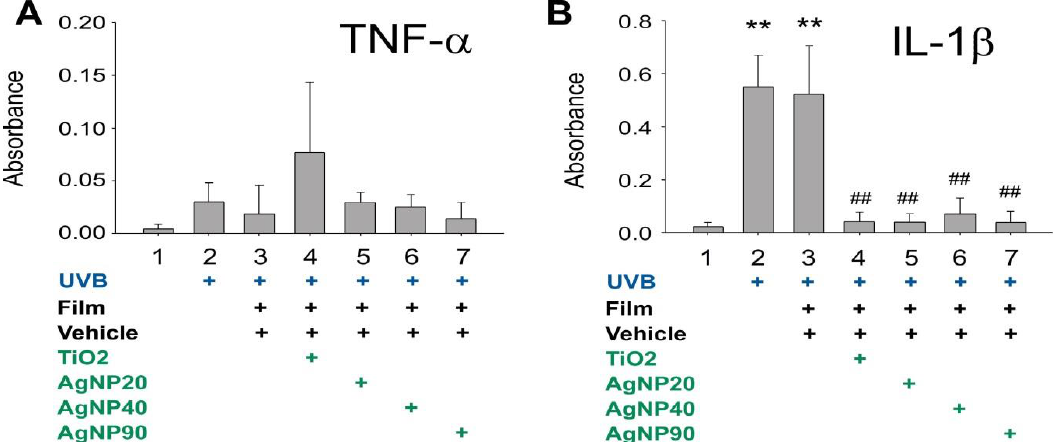
Figure 4. AgNPs rescue UVB-induced releases of proinflammatory cytokines in HaCaT keratinocyte culture. Enzyme-linked immunosorbent assay for the UVB-induced release of the proinflammatory cytokines TNF–α ( A ) and IL–1β ( B ) in a HaCaT cell culture. ** p < 0.01 vs. UVB (−) groups; p < 0.05, ## p < 0.01 vs. UVB (+) and vehicle groups. UVB, ultraviolet B; AgNP, silver nanoparticle; TiO 2 , titanium dioxide; TNF–α, tumor necrosis factor-α; IL–1β, interleukin–1β.